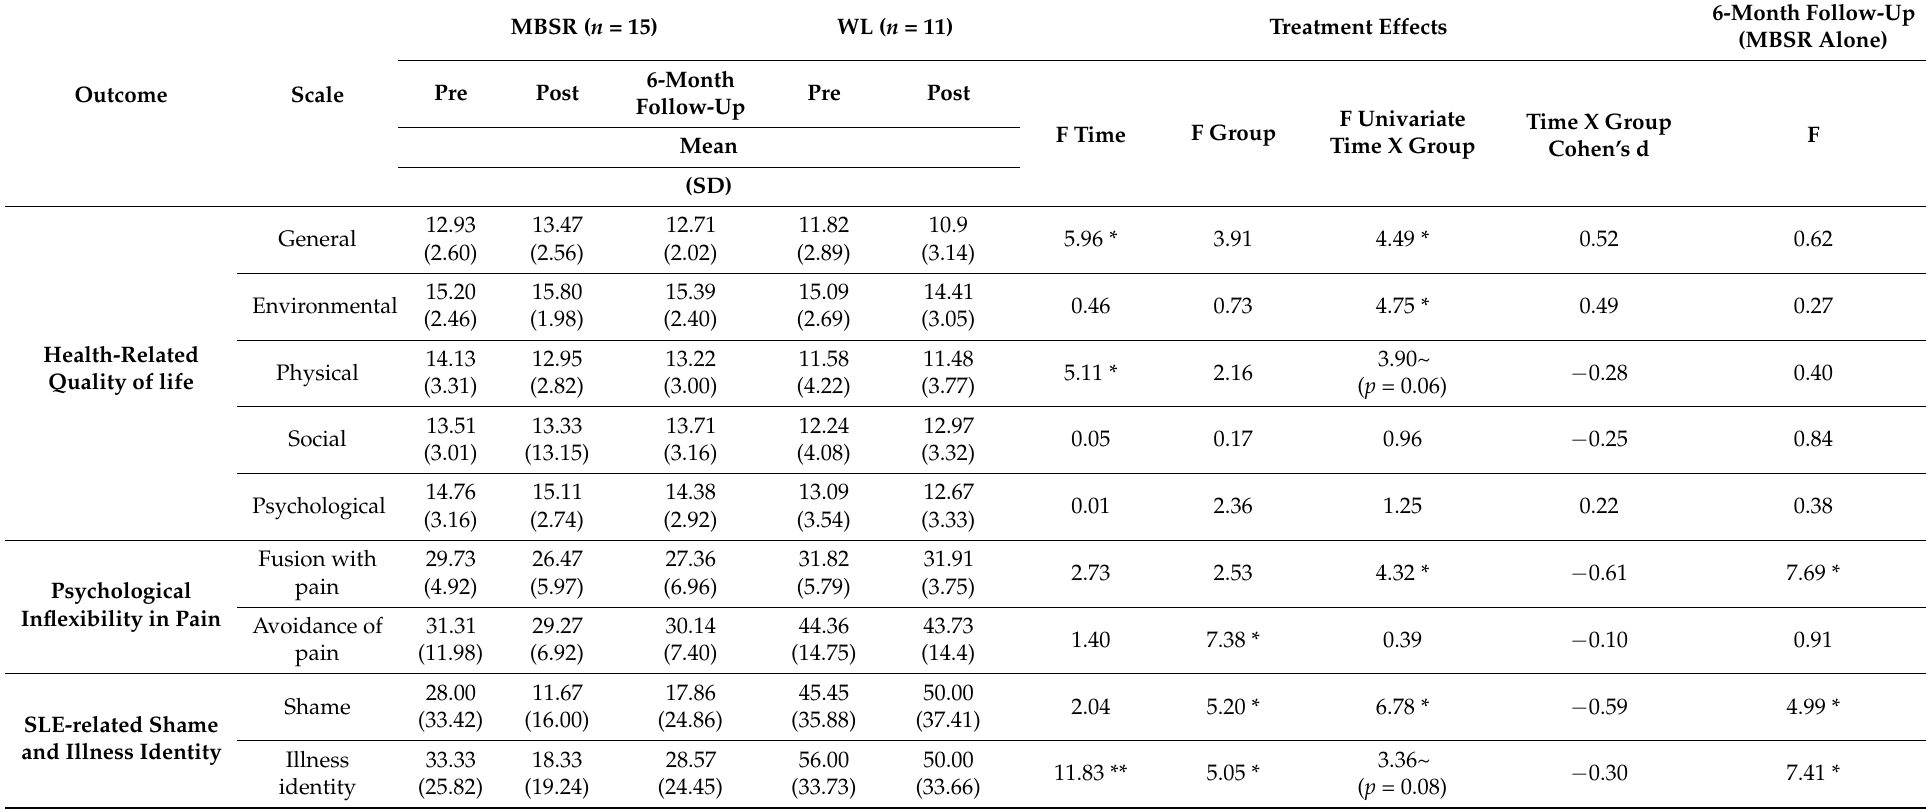
Table 3. MBSR vs. WL and MBSR follow-up effects and descriptive